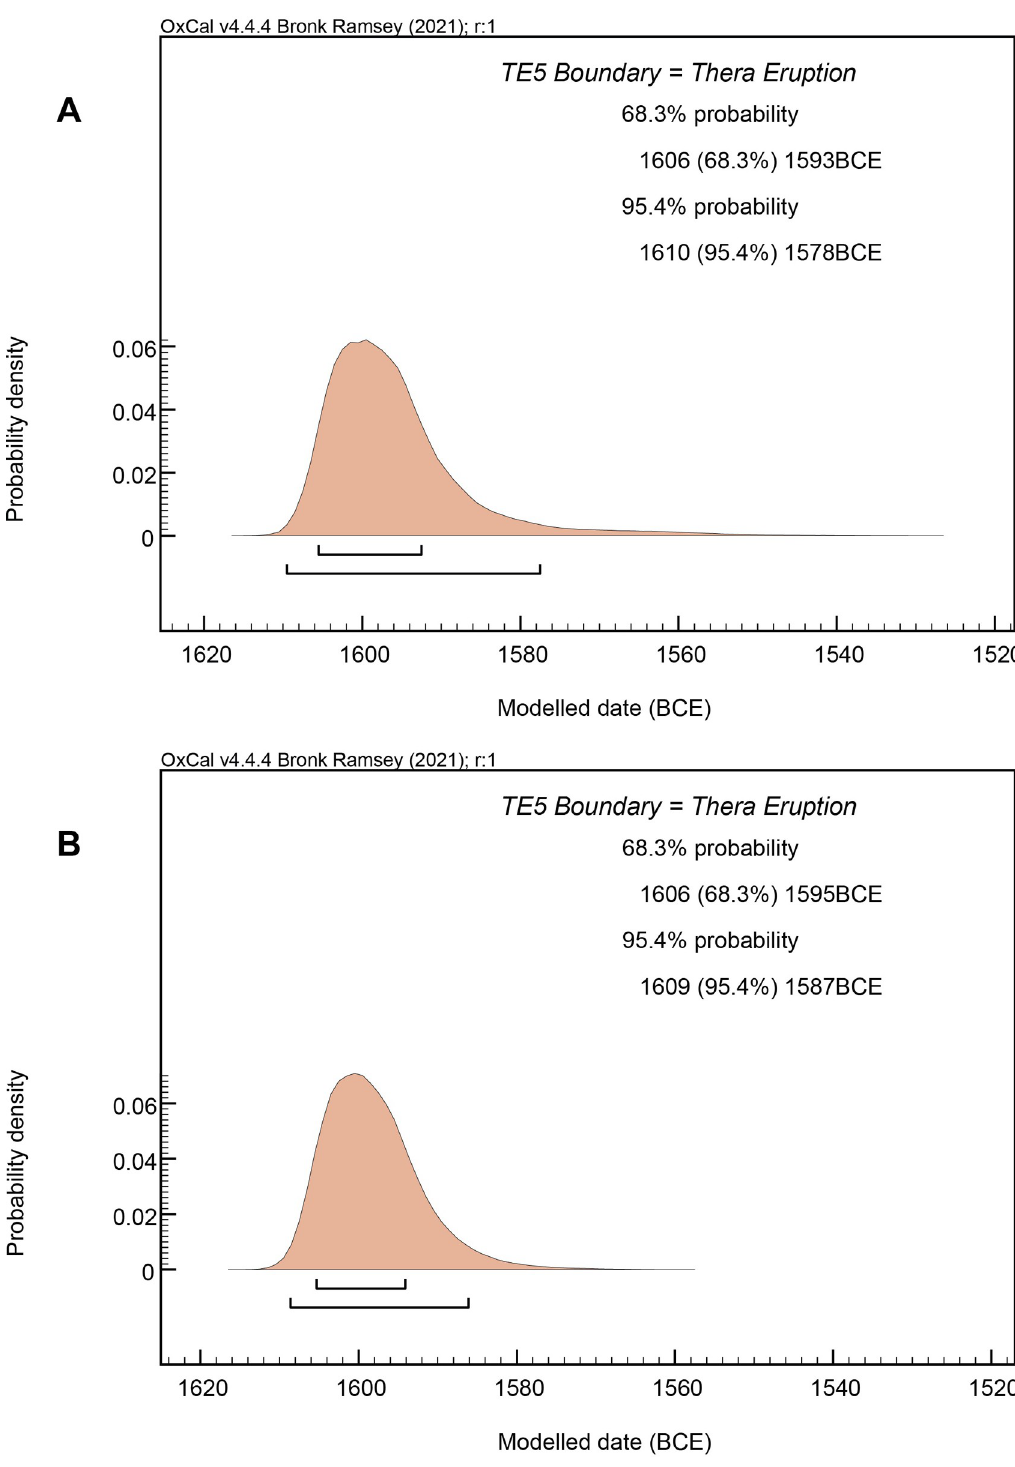
Fig 13. Dating of Akrotiri stage (v) = Thera eruption Boundary from Model 1 in Fig 9 re-run incorporating the Sofular Cave dates for likely Thera-eruption associated spikes in bromine (Br) and molybdenum (Mo) [161]. (A) with the two Sofular Cave dates treated independently, (B) with the two Sofular Cave dates